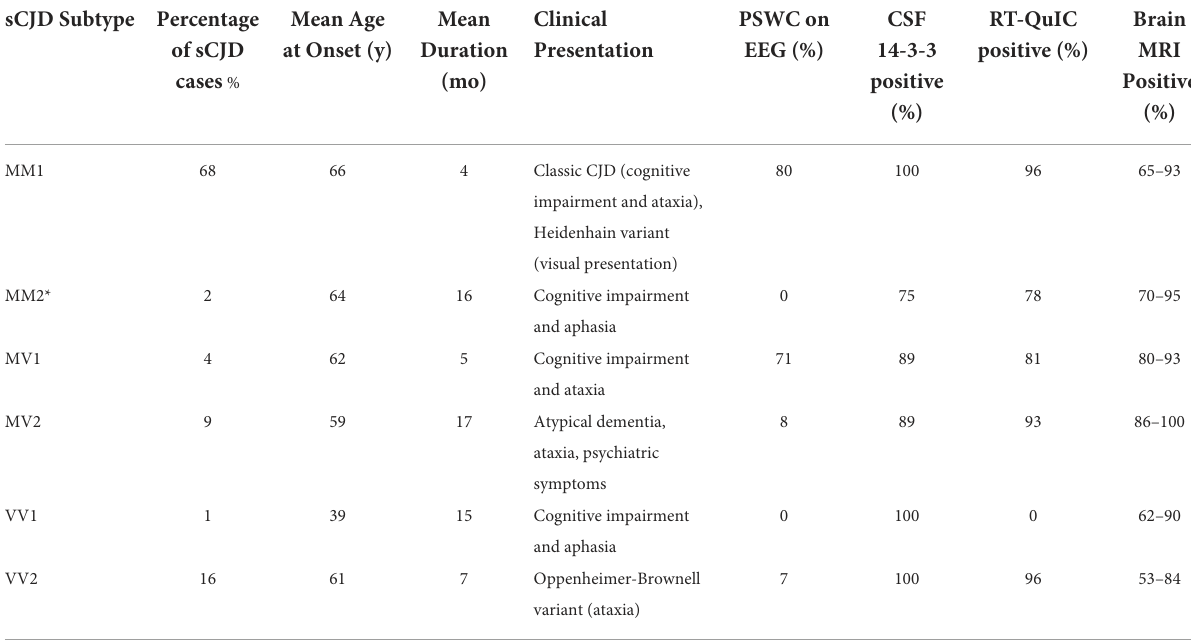
TABLE 2 Clinical characteristics of sporadic Creutzfeldt-Jakob disease (sCJD) molecular subtypes (6, 8, 23, 27). sCJD Subtype